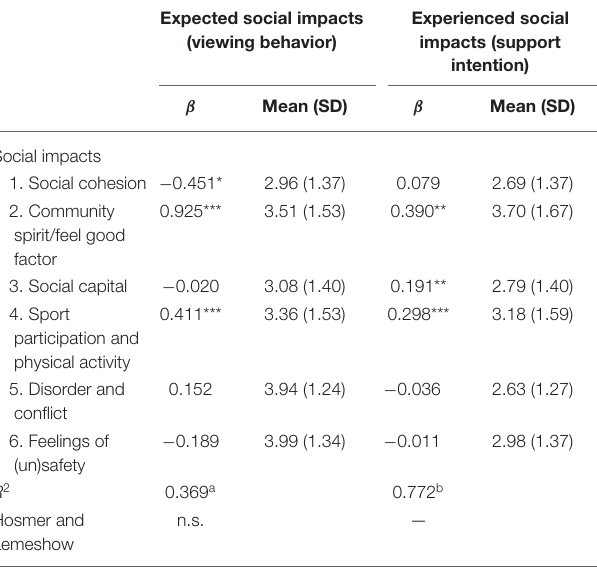
TABLE 4 | Logistic regression and multiple regression results of the expected and experienced social impacts on the viewing behavior and event support